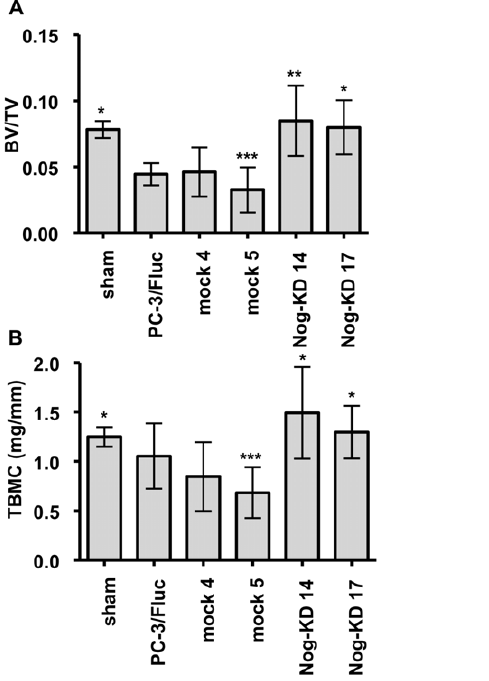
Figure 4. Noggin silencing corrects the alterations of bone structural parameters in osteolytic lesions. A . The ratio of bone volume over total volume (BV/TV, + / 2 SD) was determined by m -CT at day 25 after tumor cells inoculation; n =6–7 animals for each experimental group. *** P , 0.001, mock 5 versus Nog-KD clones and sham; ** P , 0.01, Nog-KD 14 versus PC-3/F luc and mock 4; * P , 0.05, sham and Nog-KD 17 versus PC-3/F luc and mock 4. B . Total bone mineral content (TBMC; mg/mm + / 2 SD) was measured by pQCT at day 25 after tumor cells inoculation; n =6–7 animals for each experimental group. *** P , 0.001, mock 5 versus Nog-KD 14; * P , 0.05, sham and Nog- KD 17 versus mock 5, and Nog-KD 14 versus mock 4.